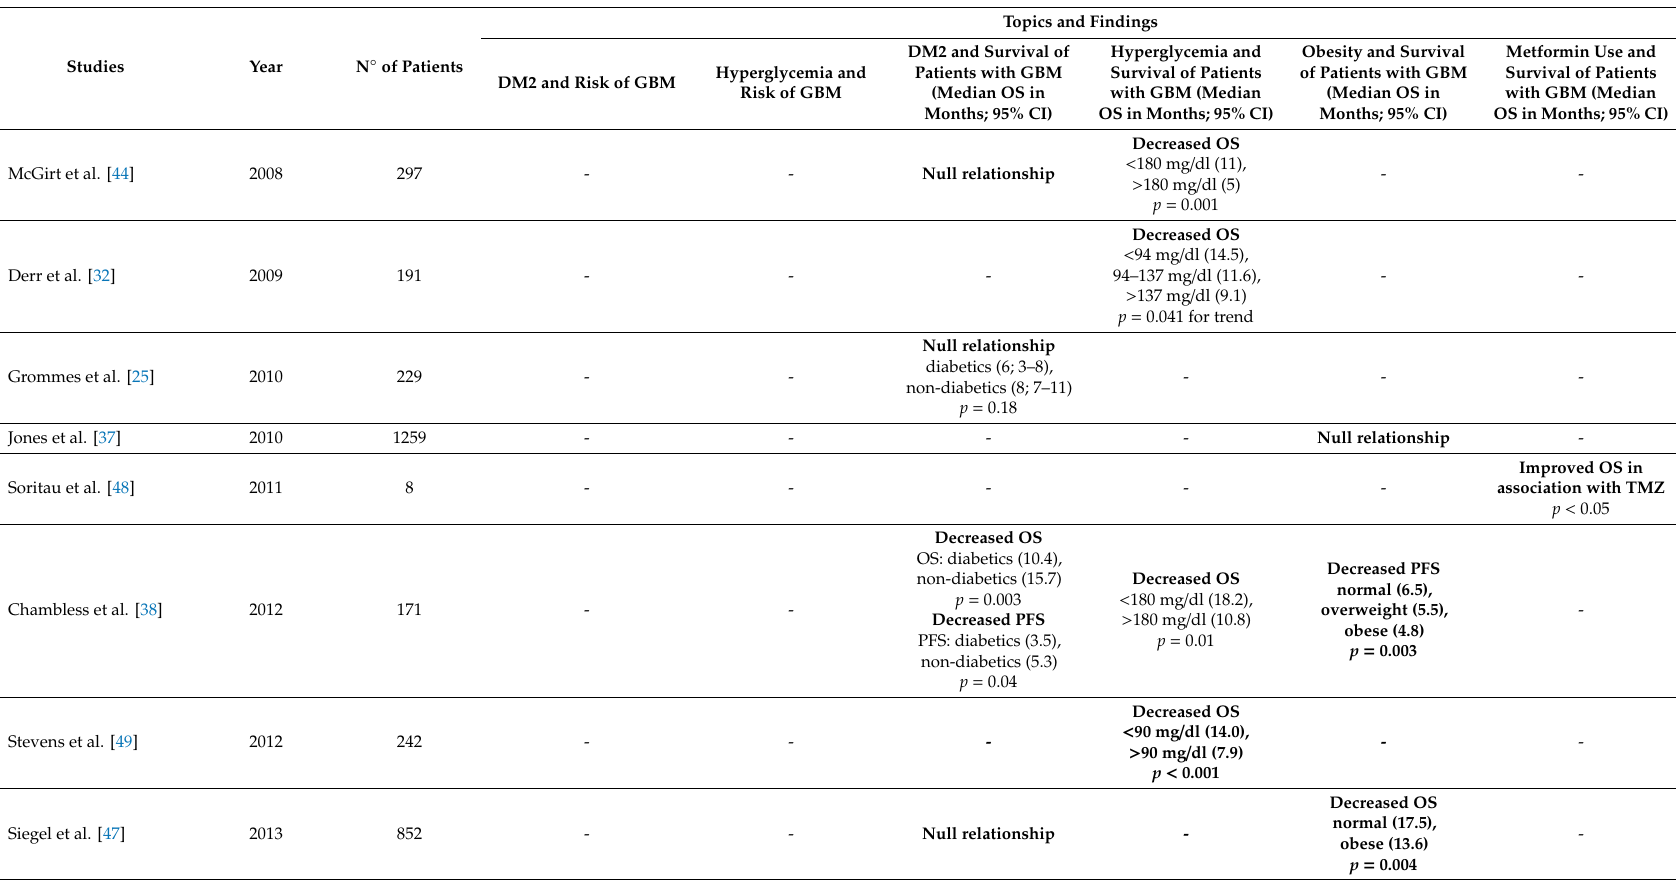
Table 2. Summary of studies included in the